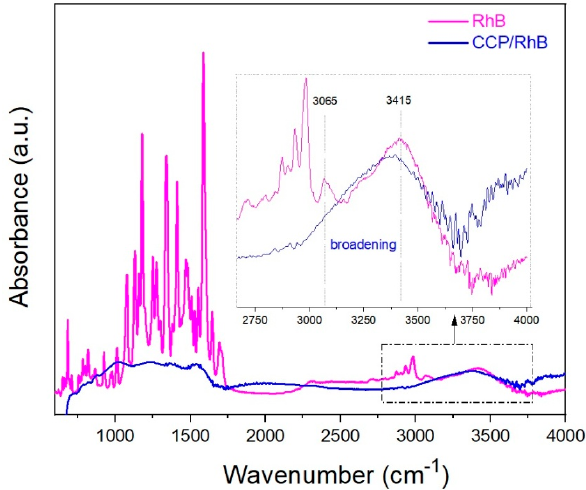
Figure 11. FTIR results of RhB (magenta line) and the “composite” material CCP/RhB (blue line) in the range 600–4000 cm − 1 . range 600–4000 cm − 1